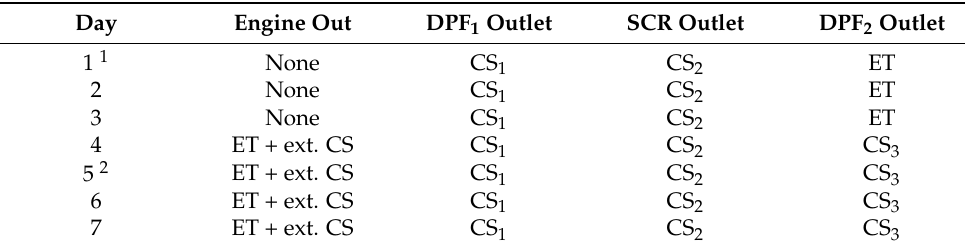
Table 2. Instrumentation